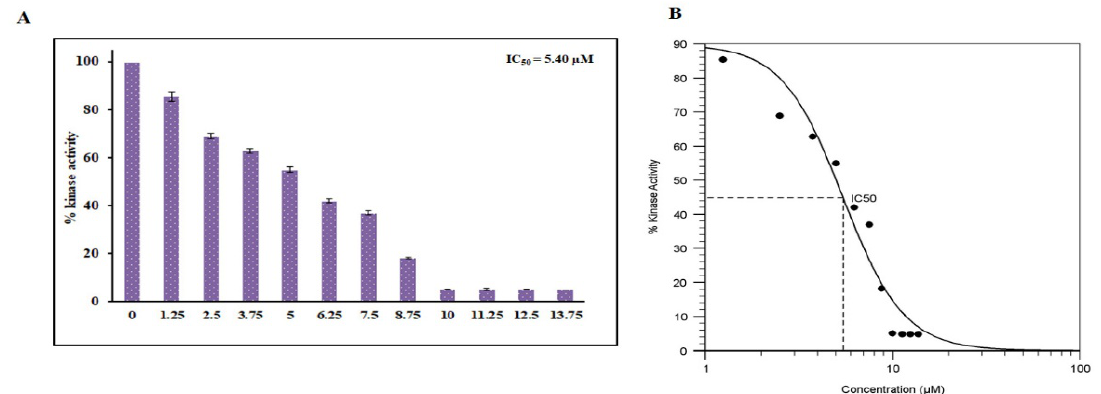
Figure 5. Enzyme inhibition studies of PDK3 with hordenine. ( A ) ATPase inhibition assay of PDK3 with increasing concentration of RA (0–13.75 µM). The activity of native PDK3 was taken as 100% for reference. ( B ) Calculation of IC 50 employing AAT Bioquest calculator.